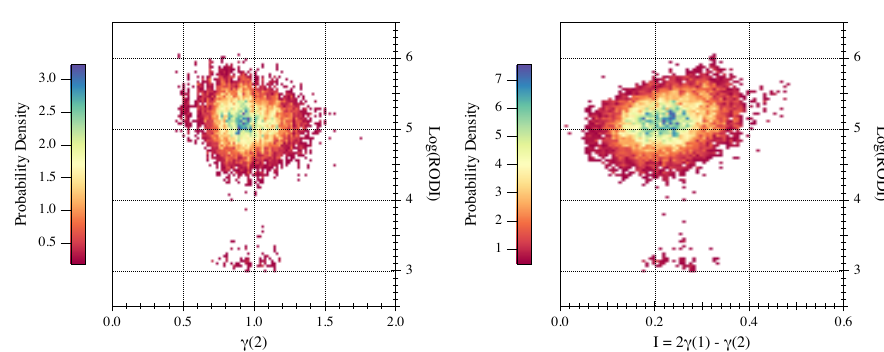
Figure 5. Joint probability densities between RODI and γ ( 2 ) (on the left ) and between RODI and Intermittency (on the right ) inside plasma